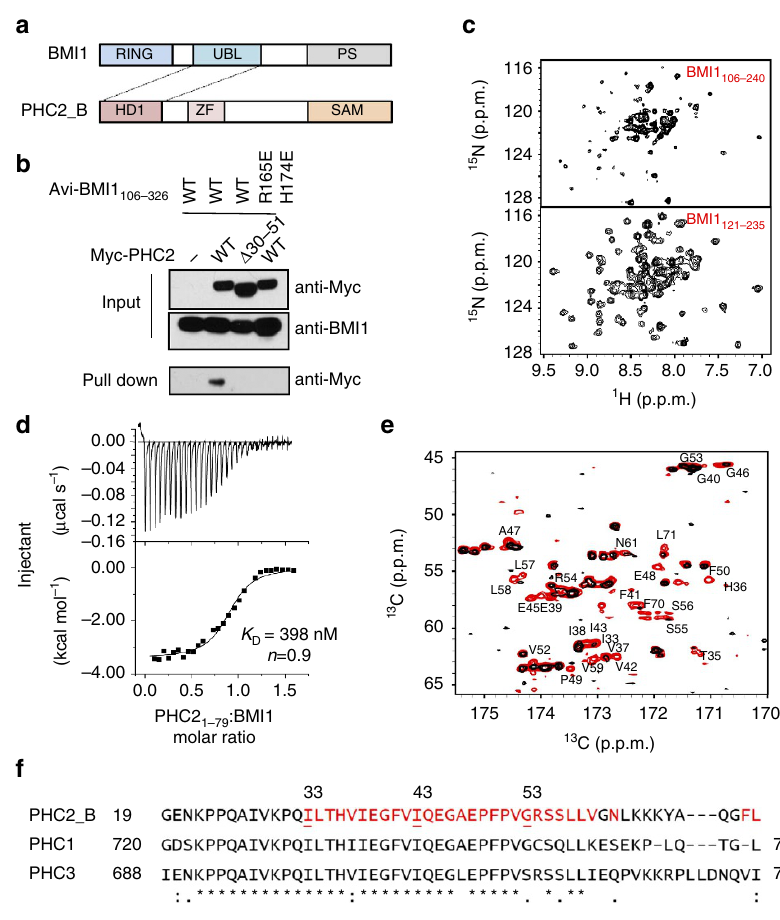
Figure 1 | Mapping of the BMI1–PHC2 interaction. ( a ) Schematics of the domain structures of BMI1 and PHC2. Dashed lines connect the interacting UBL and HD1 domains. ( b ) Streptavidin pull-down in HEK293 cells transfected with Avi-tagged wild-type BMI1 fragment 106–326 or R165E, H174E double mutant, BirA and Myc-tagged wild-type PHC2_B or PHC2_B with deleted residues 30–51. Western blots are probed as indicated. ( c ) Optimization of BMI1 constructs for structural studies: (top) 1 H– 15 N HSQC spectrum of BMI1 106–240 ; (bottom) 1 H– 15 N HSQC spectrum of BMI1 121-235 . ( d ) Characterization of the affinity and stoichiometry of the BMI1–PHC2 1–79 interaction using isothermal titration calorimetry with BMI1 121–235 titrated with PHC2 1–79 . ( e ) Superposition of CACO spectra for 60 m M PHC2 1–79 (red) and 60 m M PHC2 1–79 with equimolar concentration of unlabelled BMI1 121–235 (black). PHC2 residues broadened in the presence of BMI1 are labelled. ( f ) Sequence alignment of the three human PHC proteins. Residues of PHC2_B that are perturbed on addition of BMI1 121–235 are shown in